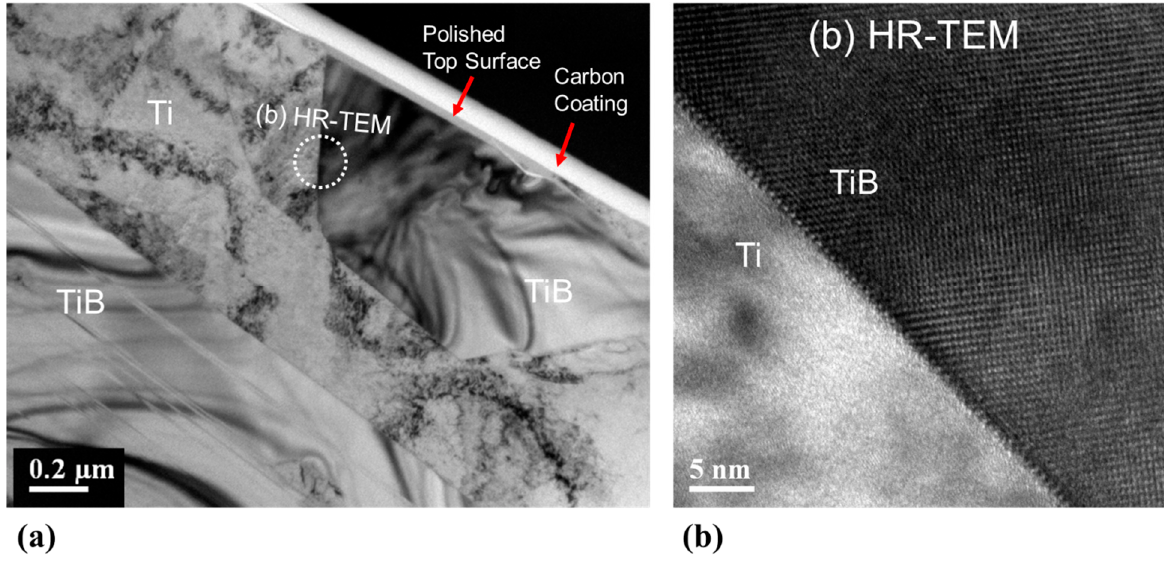
Figure 5. ( a ) Transmission electron microscopy (TEM) image taken from the enclosed dashed region highlighted in Figure 4. ( b ) High-resolution TEM image featuring a Ti–TiB interface in the material shows a coherent Ti–TiB boundary in the material, taken from the enclosed dashed rectangle region highlighted in ( a ).